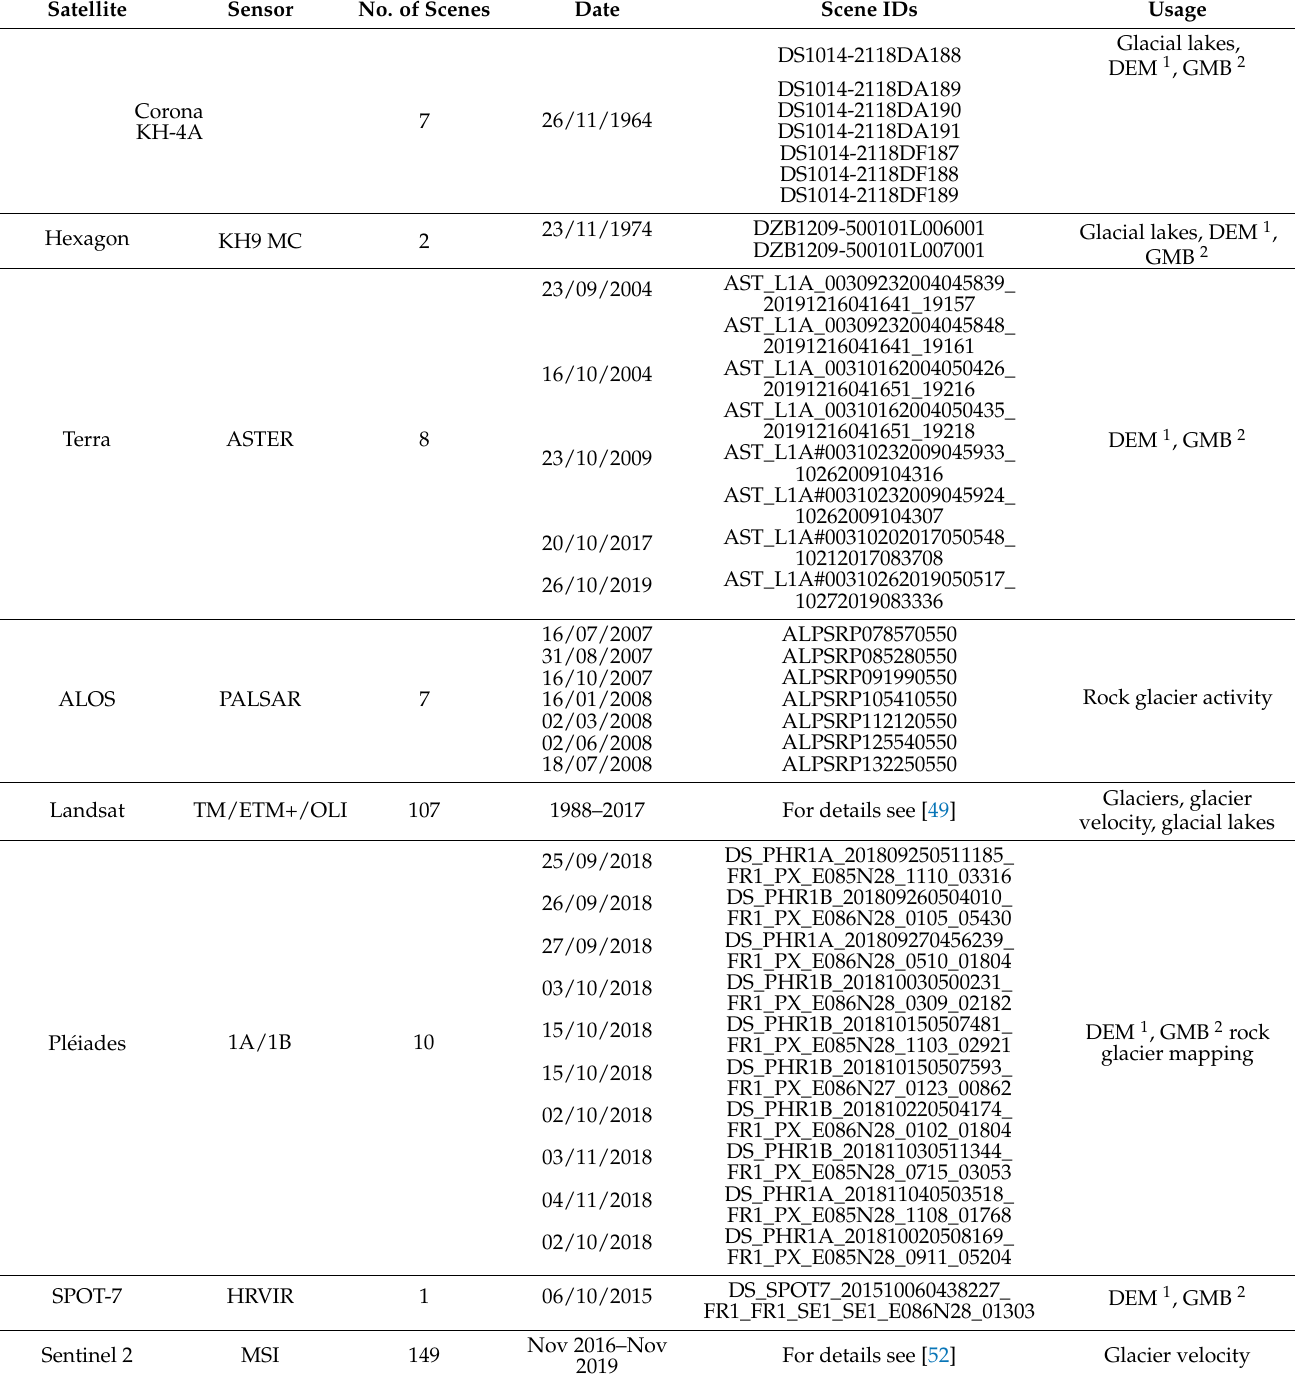
Table 1. Table 1. Satellite data used within this